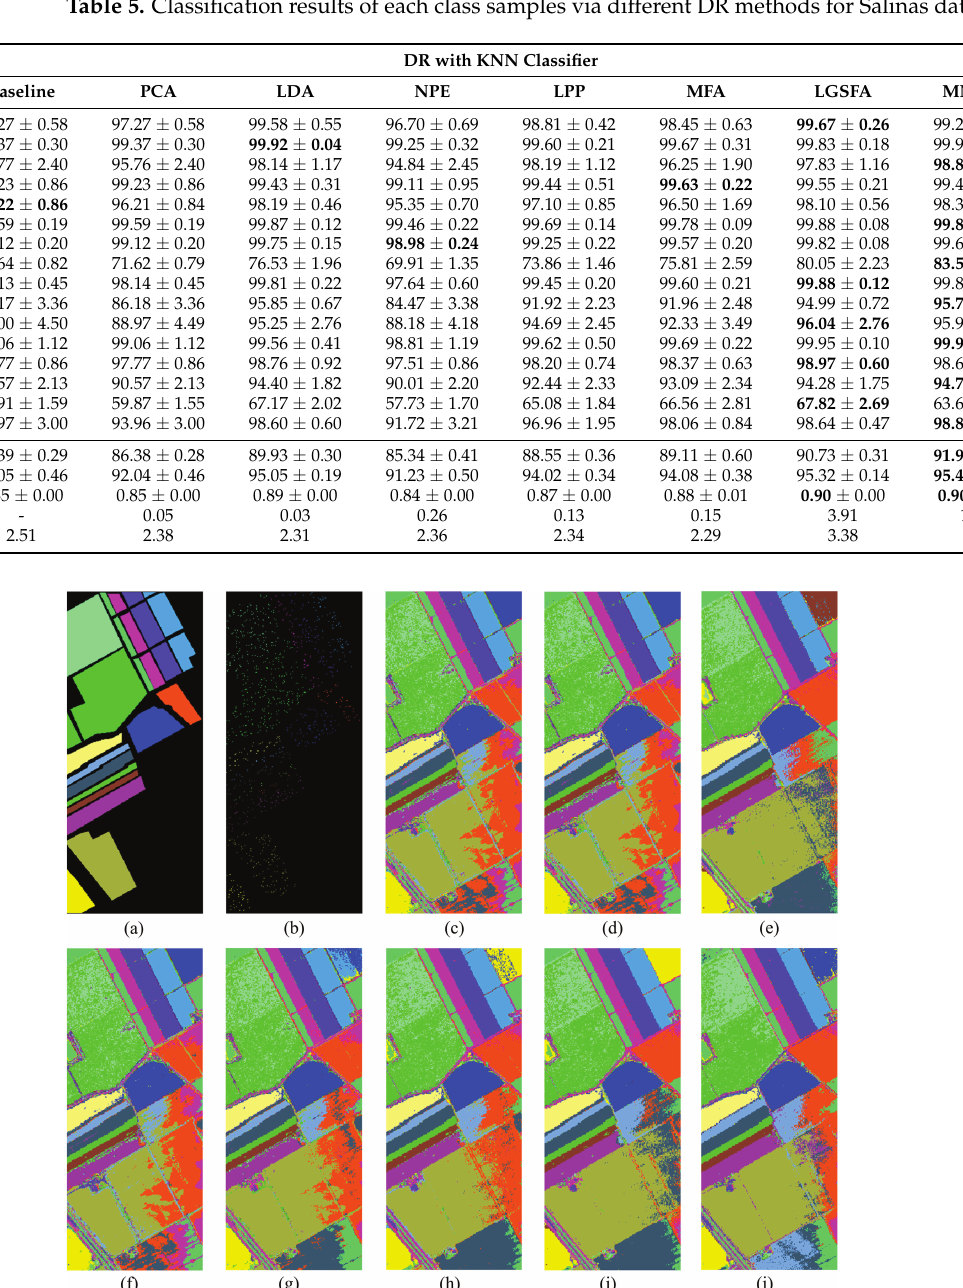
Figure 13. Classification results of different approaches for Salinas dataset. ( a ) Ground truth; ( b ) Train- ing samples; ( c ) Baseline; ( d ) PCA; ( e ) LDA; ( f ) NPE; ( g ) LPP; ( h ) MFA; ( i ) LGSFA; ( j )